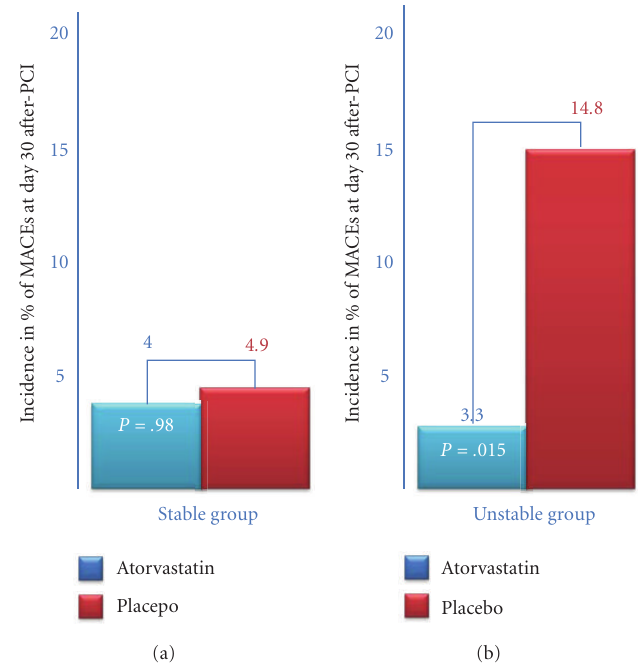
Figure 8: ARMYDA-RECAPTURE study. This modified graphic of the ARMYDA-RELOAD (RECAPTURE) study, showed with a randomized design, as compared to patients treated with placebo, the recapture e ff ect of statins. In individuals with stable and unstable coronary syndromes, chronically treated with statins and LDL < 100mg/dl, who underwent elective or semiurgent PCI, the administration of 120mg of atorvastatin before PCI significantly reduces the incidence of MACEs on day 30 after PCI. This benefit was very significant in the subgroup of individuals with unstable coronary syndromes, with an MACEs incidence of 14.8% in the placebo group versus 3.3% in the atorvastatin group with P = . 015.